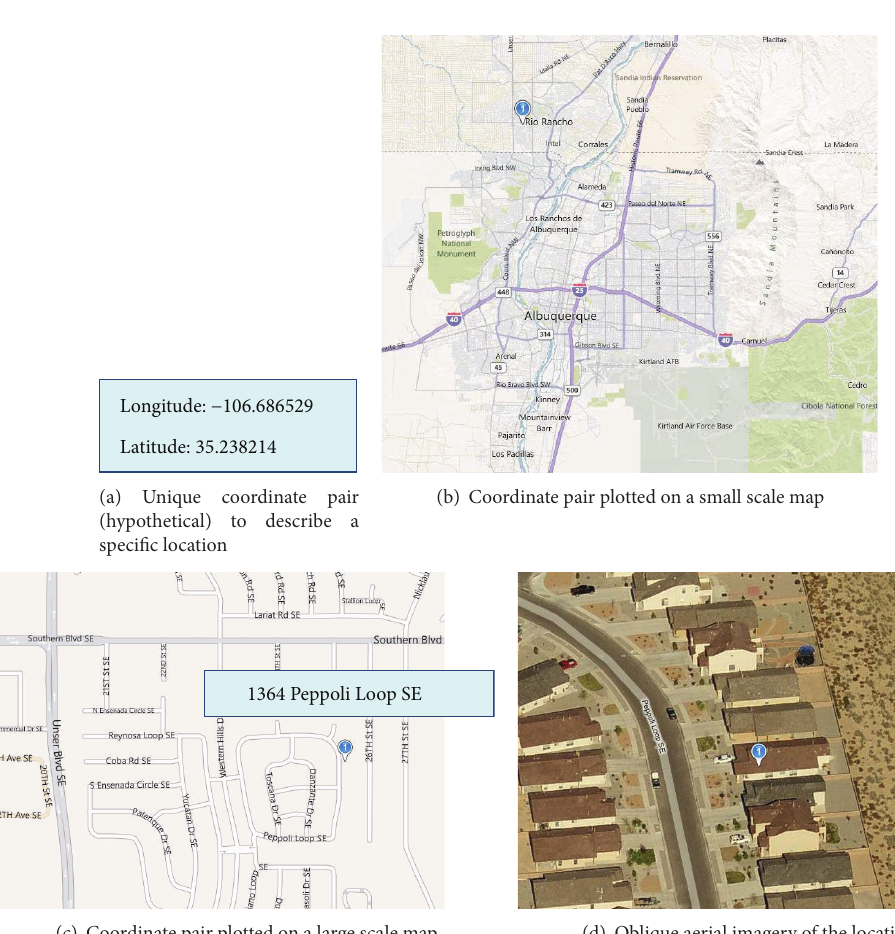
Figure 1: Disclosure of confidential information by publishing coordinates. Figure 1(a) shows an example of a hypothetical set of coordinates. Plotting these on a small scale map (b) provides an approximate location (i.e., Rio Rancho). Zooming in using a large scale map (c) provides a very exact location, which can be used to identify the street address associated with the set of coordinates (e.g., 1364 Peppoli Loop SE). Aerial imagery (d) can be used to confirm the specific residence.